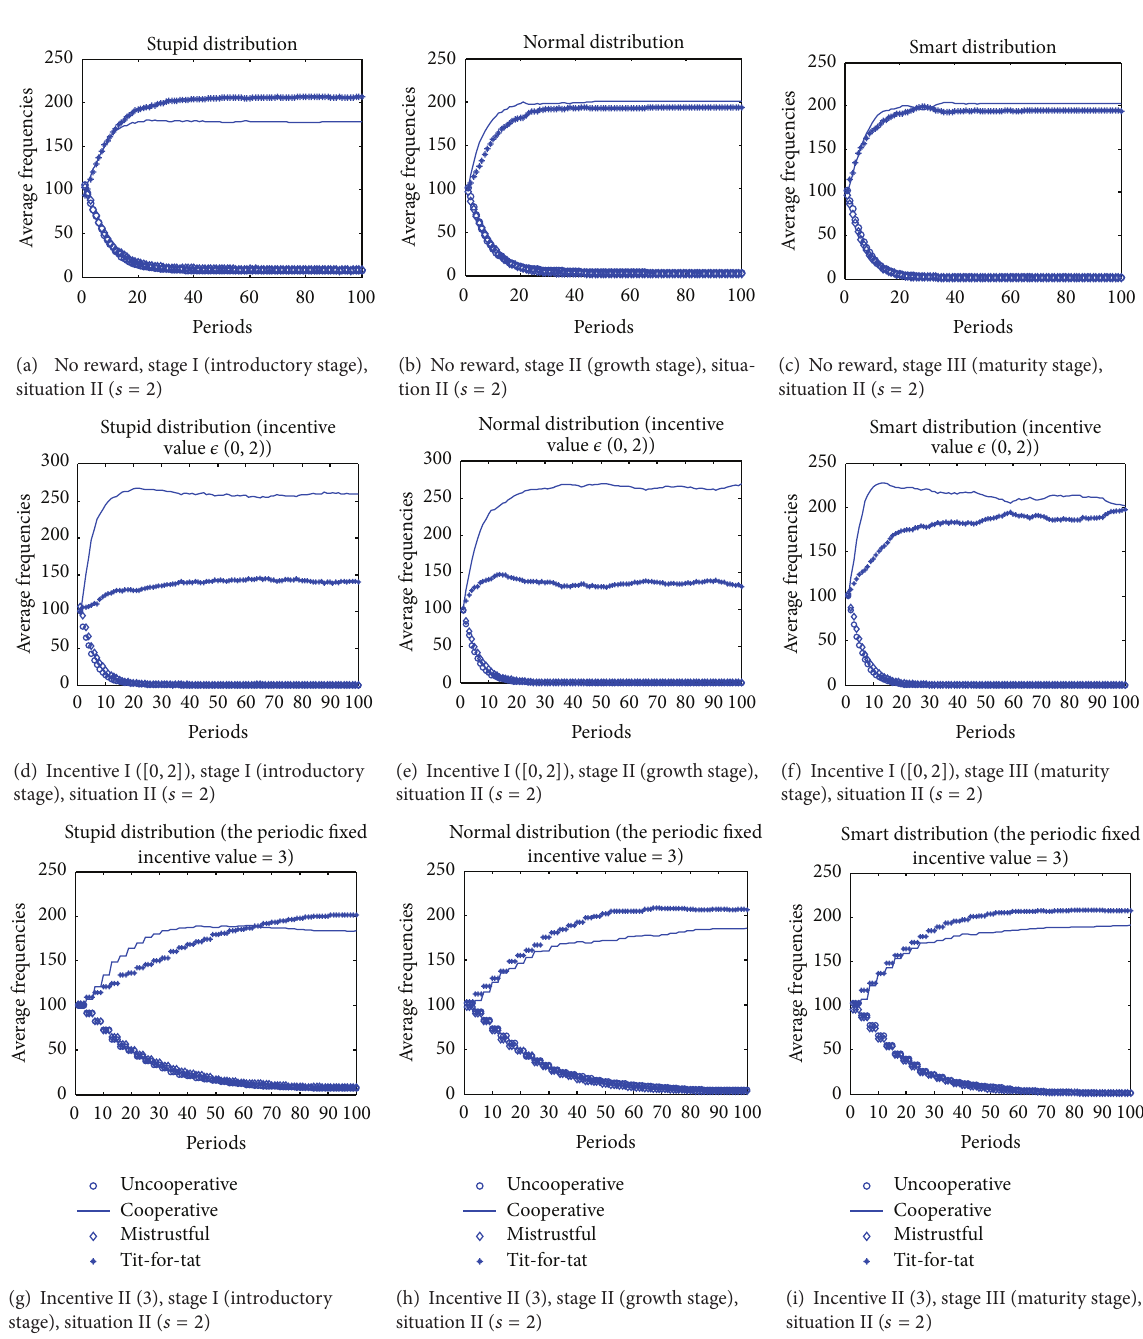
Figure 2: Dynamics about agents’ strategy change in different stages in situation II of